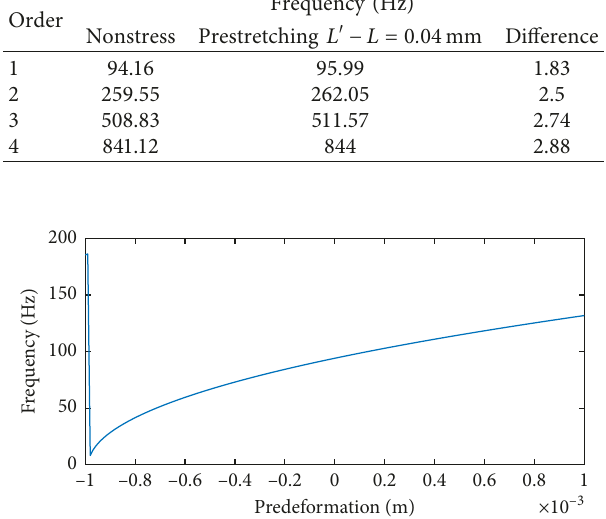
Figure 6: Effect of the predeformation on the first-order natural frequency.